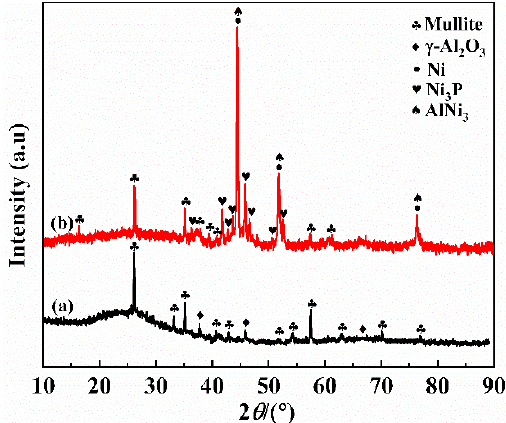
Figure 9. XRD patterns of the as-sprayed coatings: ( a ) O C , ( b ) N C .